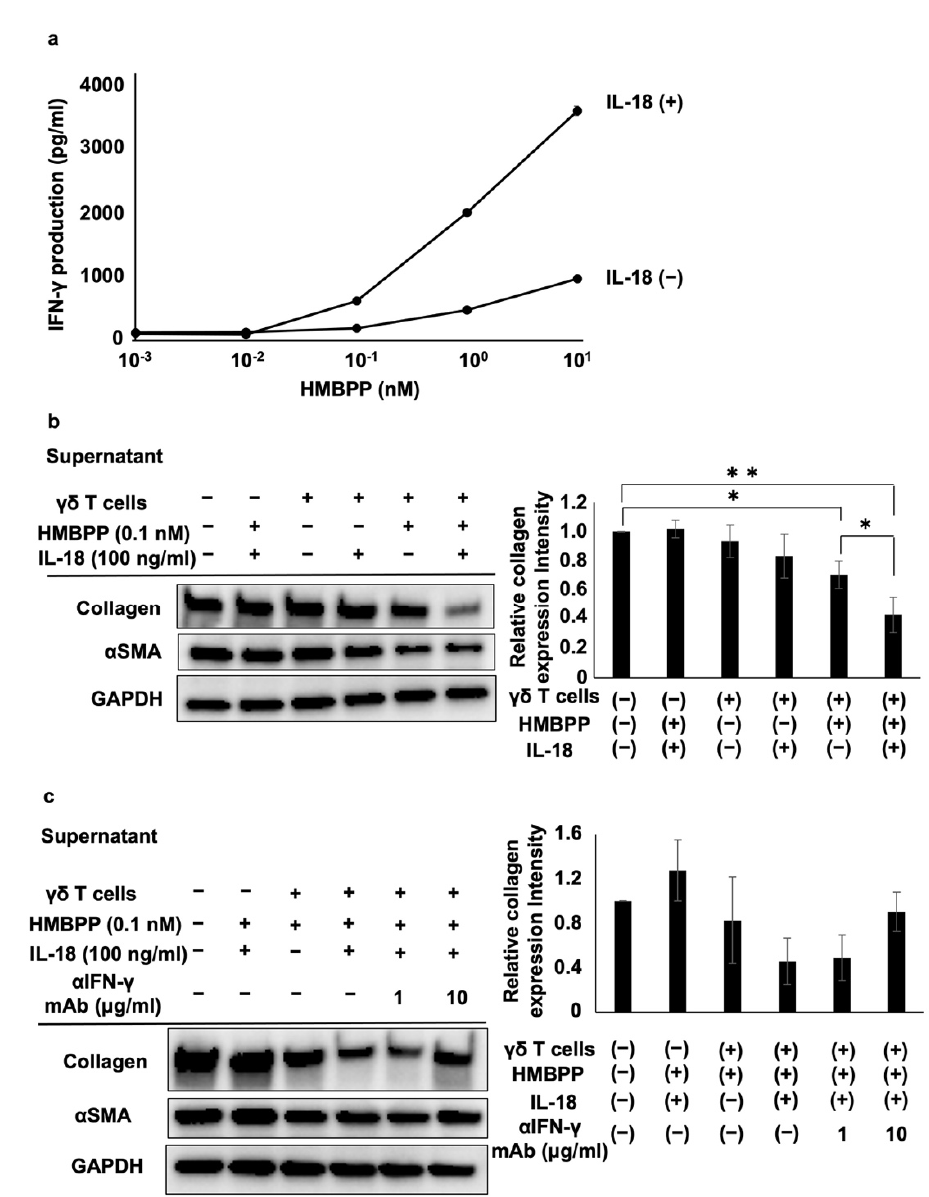
Figure 6. Effect of IL-18 on the suppression of collagen type I and α SMA in lung fibroblasts by HMBPP-stimulated γδ T cell supernatant. ( a ) Effect of IL-18 on IFN- γ secreted from HMBPP-activated γδ T cells. γδ T cells (4 × 10 5 ) were stimulated for 24 h in a 96-well flat-bottom plate using serial dilutions of HMBPP (0.001, 0.01, 0.1, 1, or 10 nM) in the presence or absence of IL-18 (100 ng/mL). Supernatants were collected and IFN- γ levels were measured via ELISA. ( b ) Effect of IL-18 on collagen type I and α SMA levels in lung fibroblasts treated with HMBPP-stimulated γδ T cell culture supernatants. DHLF cells (1.5 × 10 5 ) were cultured overnight in a 6-well plate. After supernatants were aspirated, culture supernatants (1 mL each) of γδ T cells treated with or without HMBPP (0.1 nM) in the presence or absence of IL-18 (100 ng/mL) were added to the wells. The plate was incubated for 2 days, and collagen type I and α SMA levels in DHLF cells were analyzed via Western blot analysis. Relative collagen expression was calculated by normalization to GAPDH. treated with HMBPP/IL-18-stimulated γδ T cell culture supernatants. DHLF cells (1.5 × 10 5 ) were cultured overnight in a 6-well plate. After the supernatants were aspirated, anti-IFN- γ mAb (0, 1, or 10 µ g/mL) and culture supernatants (1 mL) of γδ T cells incubated overnight with HMBPP (0.1